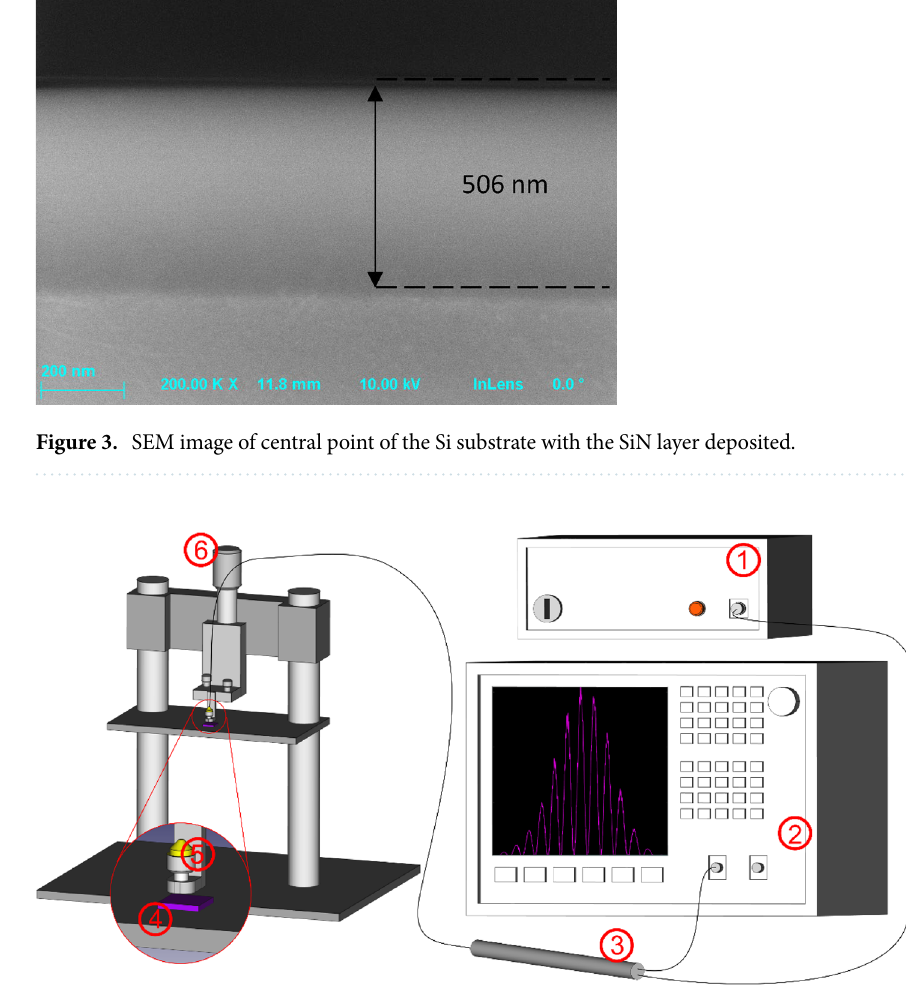
Figure 4. Measurement setup, 1—light source, 2—optical spectrum analyser, 3—fiber coupler, 4—investigated SiN layer, 5—fiber end-face, 6—micrometric